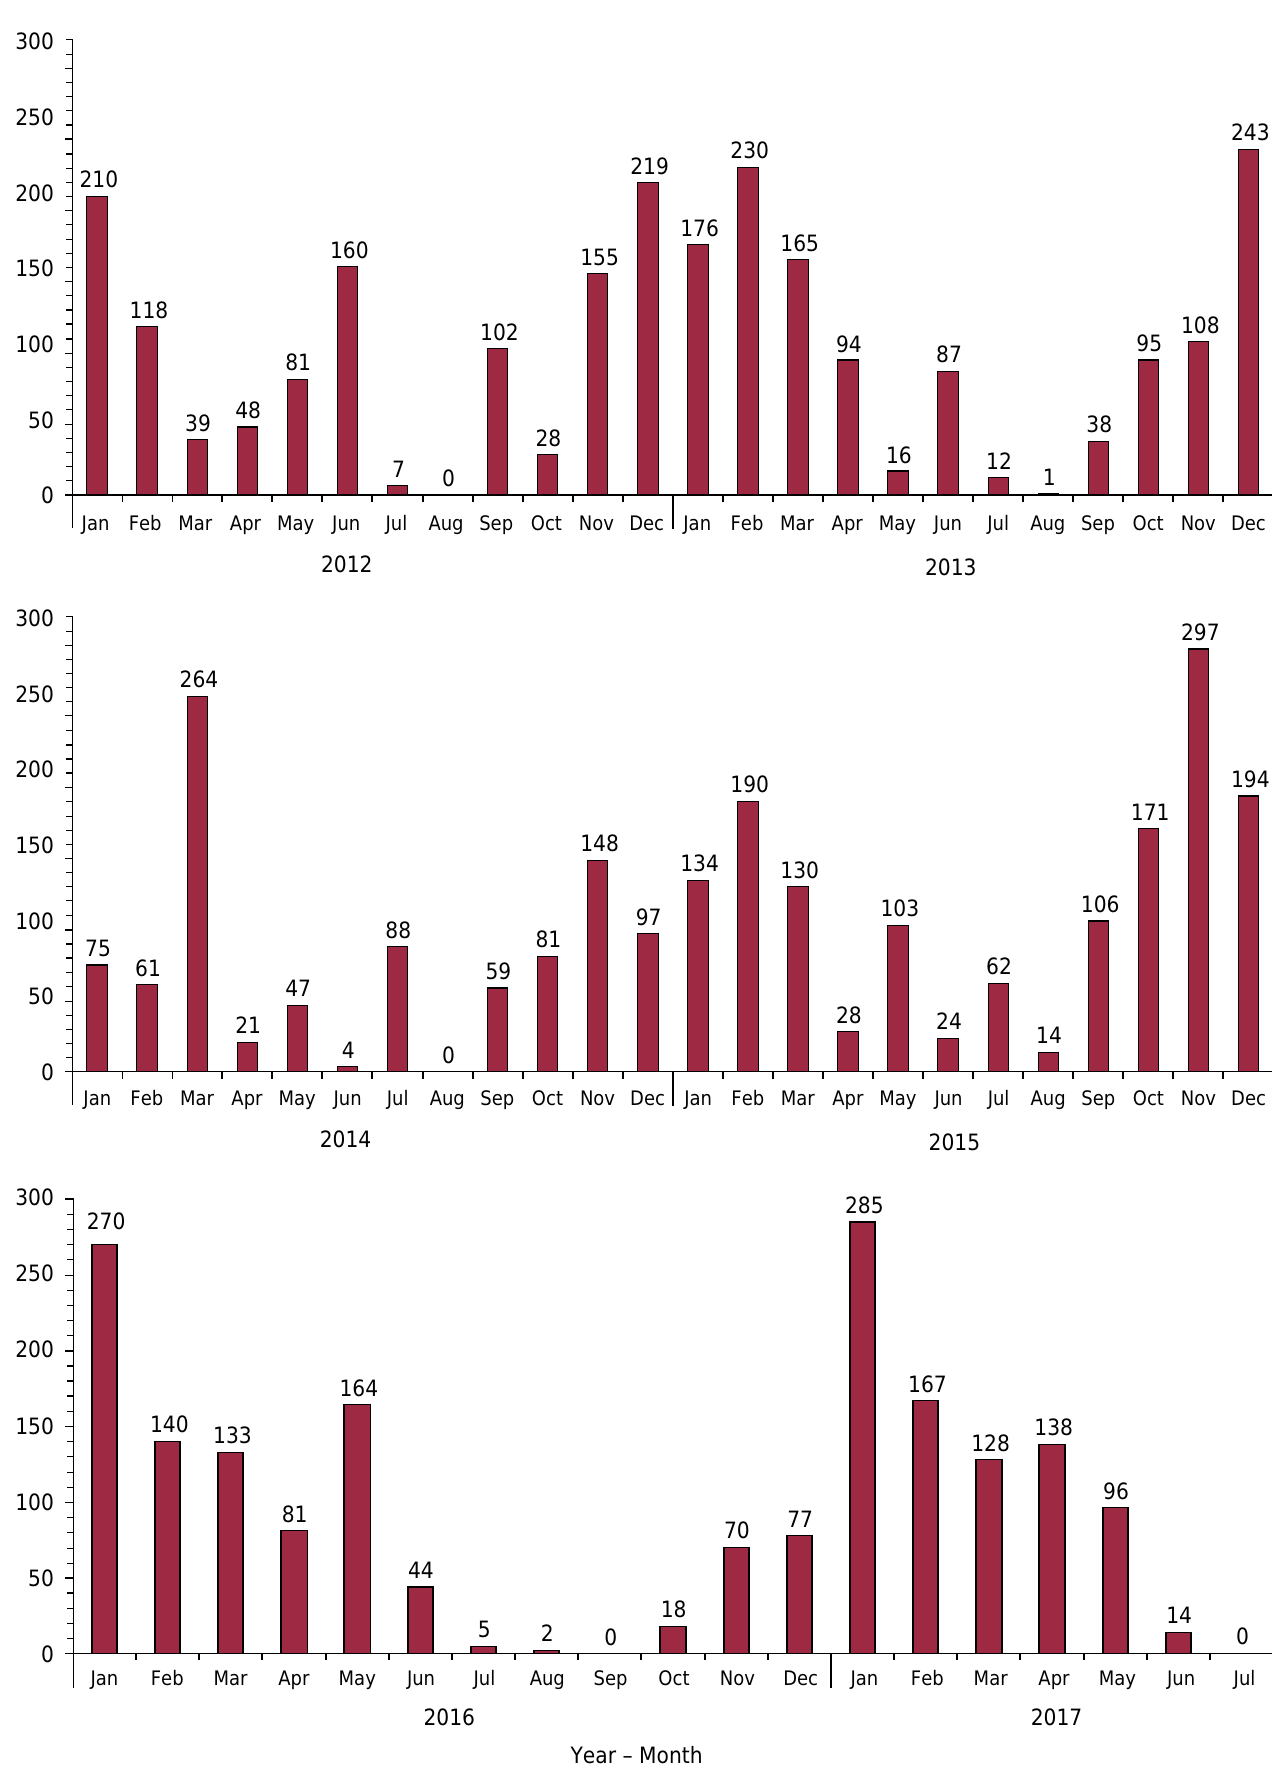
Figure 1. Monthly accumulations of rainfall registered at the Três Lagoas Automatic Meteorological Station,